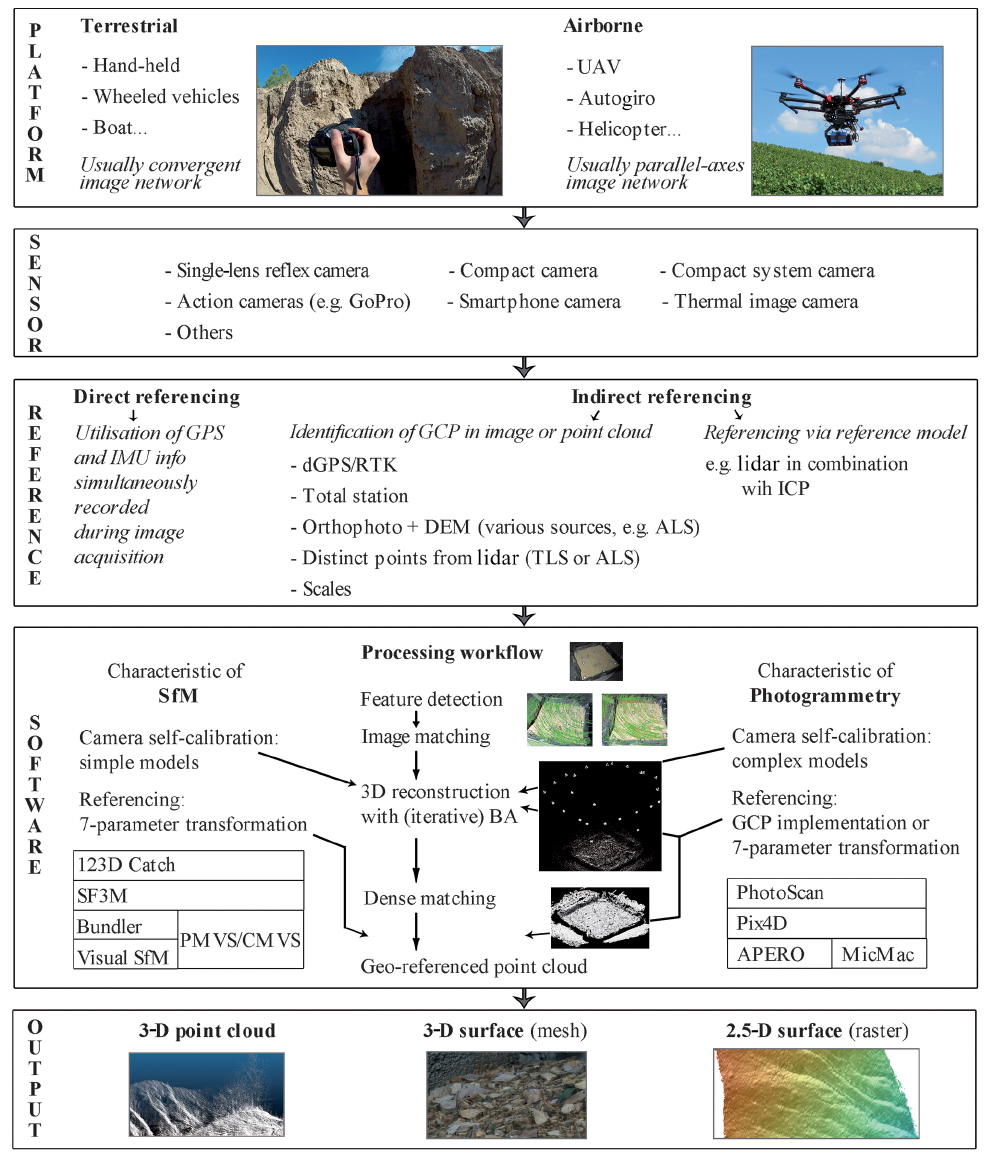
Figure 1. Schematic illustration of the versatility of SfM photogrammetry.